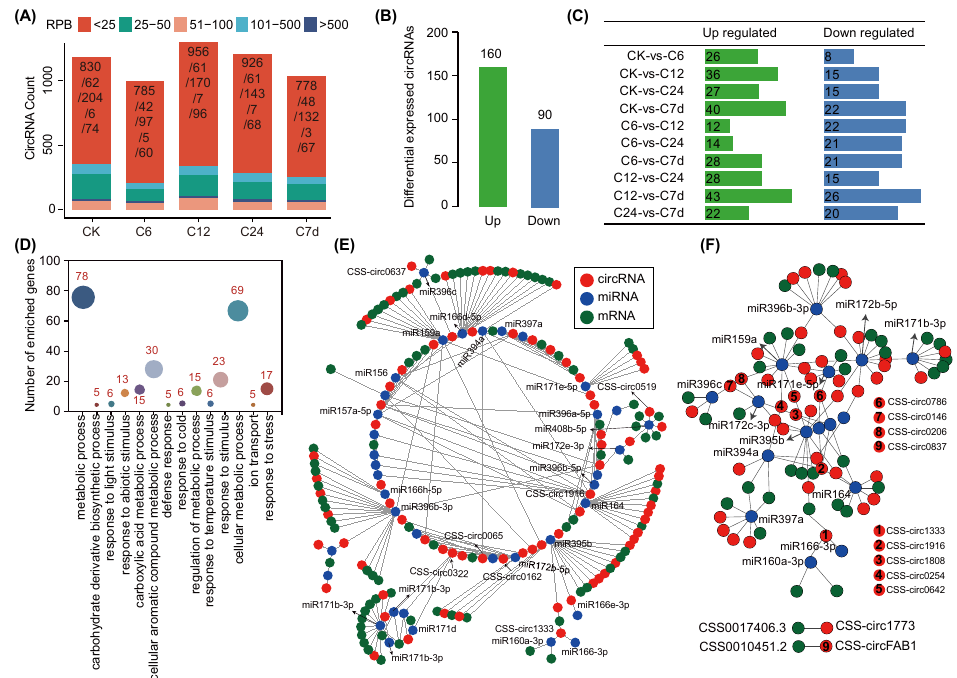
Figure 3. Differential expression and interaction network analysis of circRNAs in tea plant. ( A ) The expression pattern of circRNAs using RPB (junction reads per billion clean reads). ( B ) Differen- tially expressed circRNAs identified under chilling stress in tea plant. ( C ) Up- and down-regulated circRNAs identified among different comparisons. ( D ) Functional annotation of differentially ex- pressed circRNAs. ( E ) circRNA-miRNA-mRNA interaction network of tea plant under chilling stress. ( F ) The key circRNAs potentially interacting with well-known cold-related miRNAs in the network are